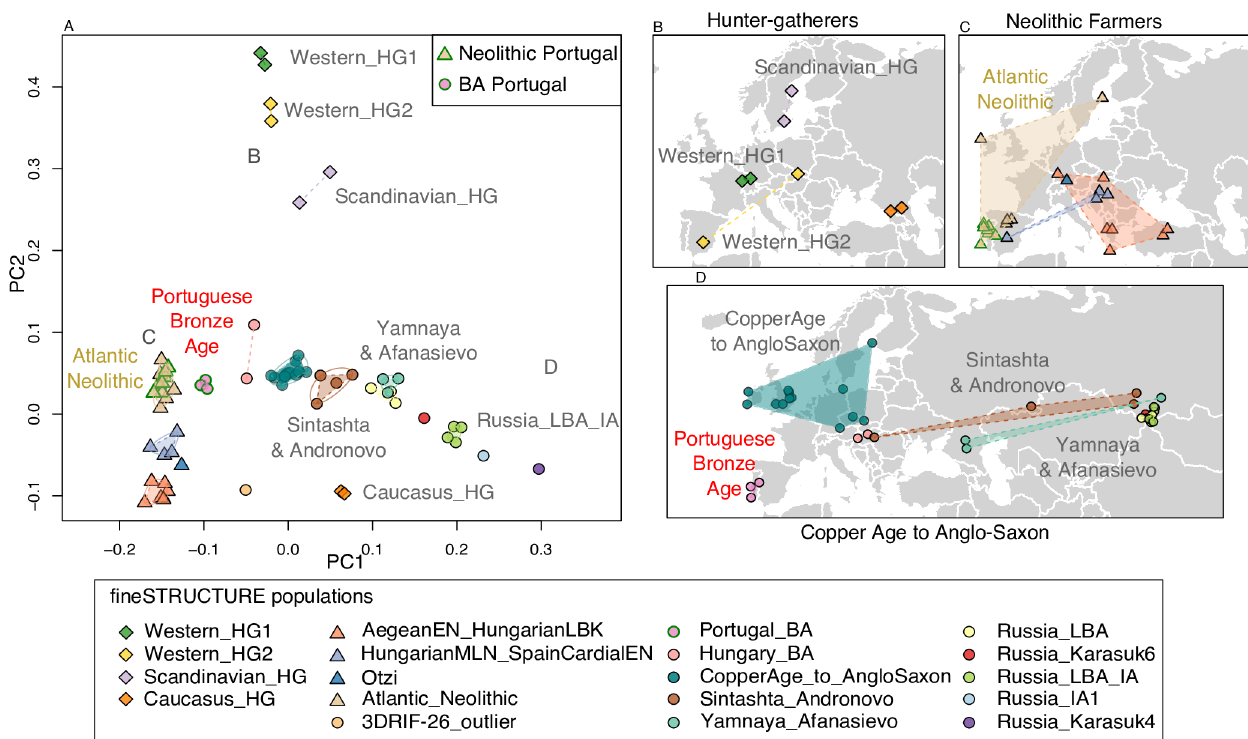
Fig 1. CHROMOPAINTER/fineSTRUCTURE analysis. (A) PCA estimated from the CHROMOPAINTER coancestry matrix of 67 ancient samplesrangingfrom the Paleolithicto the Anglo-Saxon period. The samplesbelongingto each one of the 19 populationsidentifiedwith fineSTRUCTURE are connectedby a dashedline. Samplesare placedgeographically in 3 panels (with random jitter for visual purposes): (B) Hunter-gatherers; ( C) NeolithicFarmers (includingO¨ tzi) and ( D) Copper Age to Anglo-Saxon samples. The Portuguese Bronze Age samples (D, labelledin red) formed a distinct population ( Portuguese_BronzeAge ), whilethe Middle and Late Neolithicsamples from Portugal clusteredwith Spanish, Irish and Scandinavian Neolithicfarmers, which are termed “ Atlantic_Neolithic ”(C, in green).